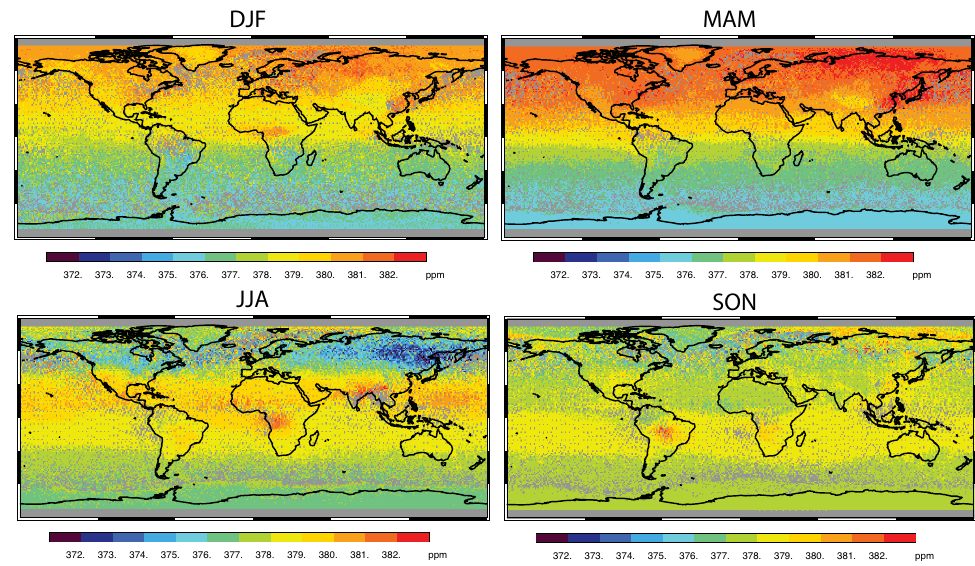
Fig. 3. Seasonal variation in x CO 2 representing the mean of all models sampled like A-SCOPE for the year 2005.